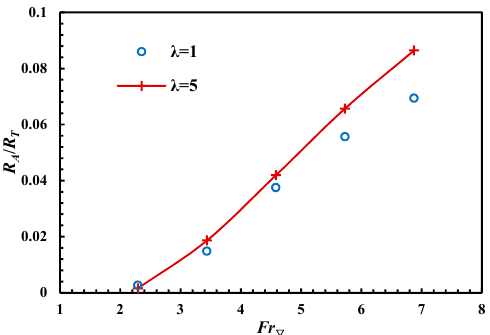
Figure 16. The proportion of aerodynamic resistance in total resistance.